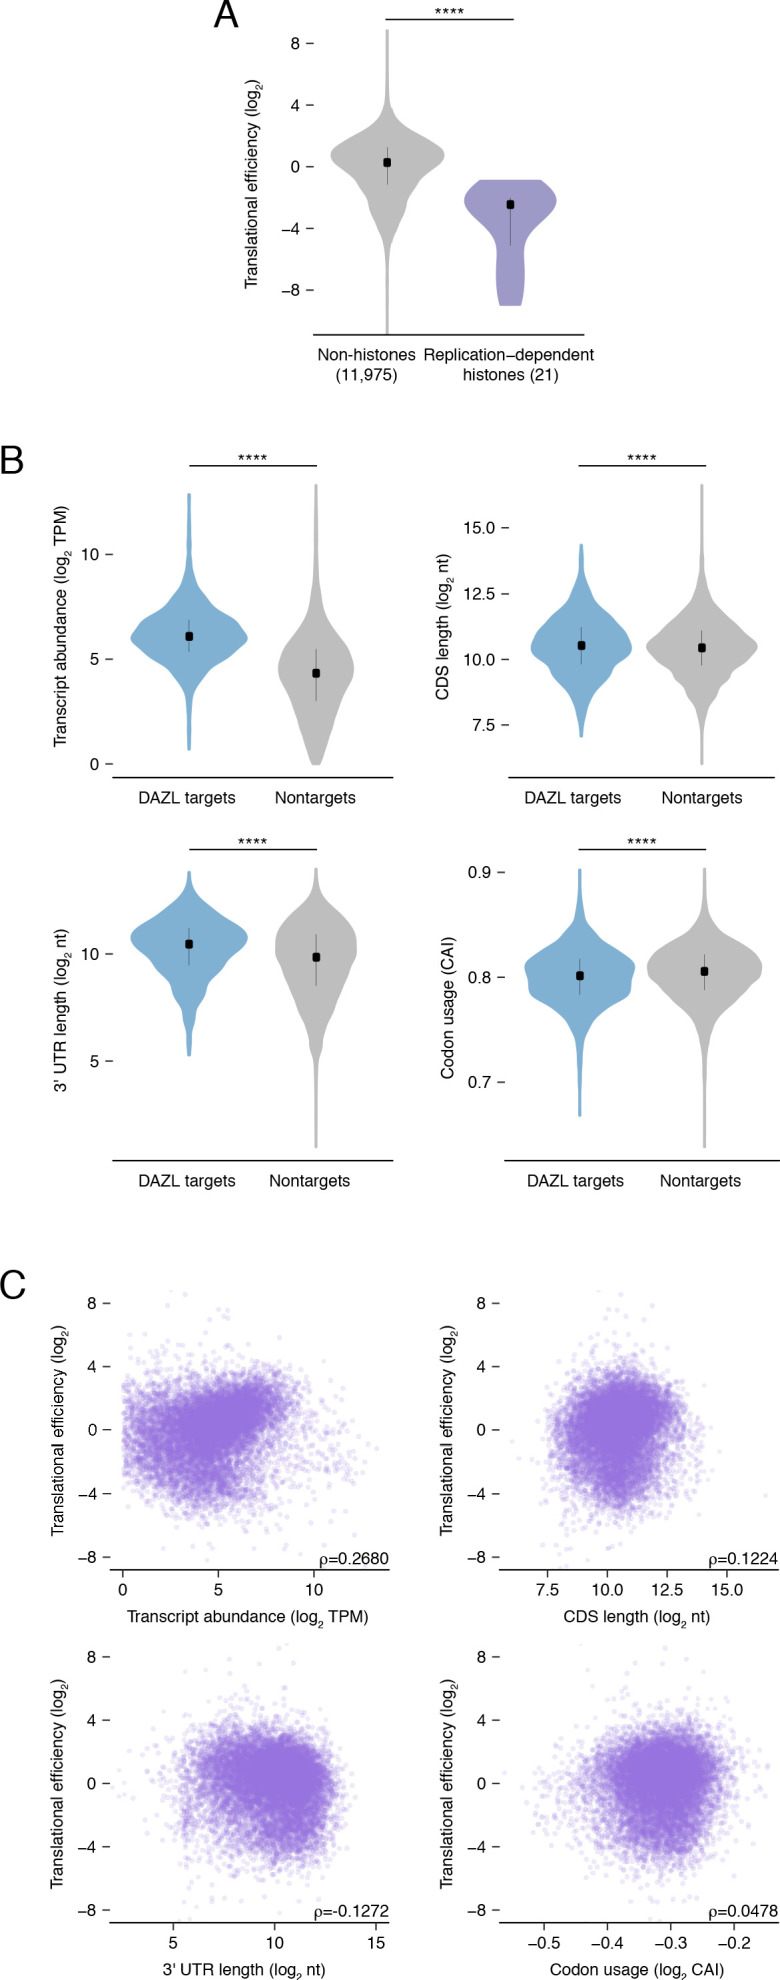
Translational efficiency in undifferentiated spermatogonia.(A) Replication-dependent histones show reduced translational efficiency compared with the average transcript in undifferentiated spermatogonia. This is expected, as the undifferentiated spermatogonia here were not synchronized for S phase, when these histones are robustly translated (two-sided Mann-Whitney U test). (B) DAZL targets are distinct from nontargets in variables known to correlate with translational efficiency: transcript abundance, CDS length, 3' UTR length, and codon usage (CAI) (two-sided Kolmogorov-Smirnov tests). (C) Relationships between translational efficiency and variables known to correlate with translation efficiency: transcript abundance, CDS length, 3' UTR length, and codon usage. ****, p<0.0001.